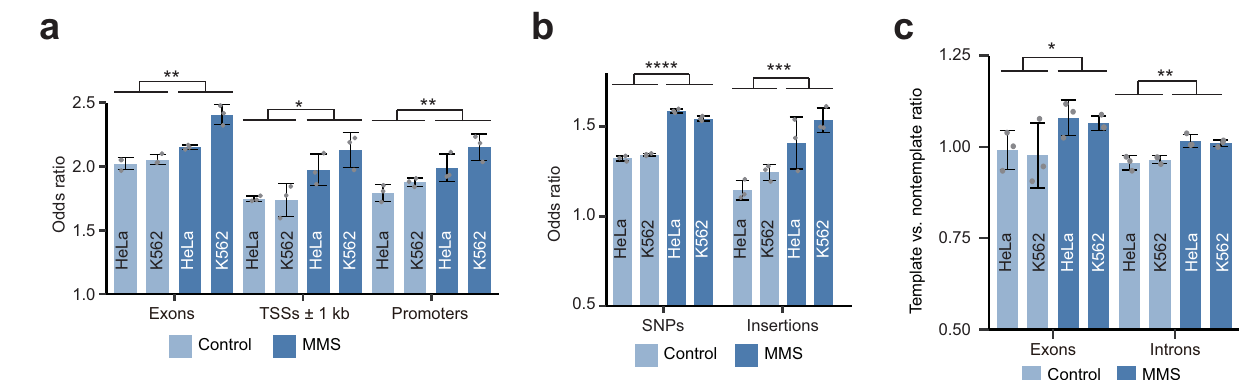
Fig. 6 | Properties of sample-level AP site hotspots in human cell lines treated with MMS. a Enrichment of hotspots in exons, introns and promoters in the samples treated with MMS (methyl methanesulfonate) and the corresponding controls in HeLa and K562 cell lines. b Enrichment of hotspots at SNPs and inser- tionsinMMS-treatedandcontrolsamplesinHeLaandK562celllines. c Distribution of template vs. nontemplate ratios for hotspots in the exons and introns in the